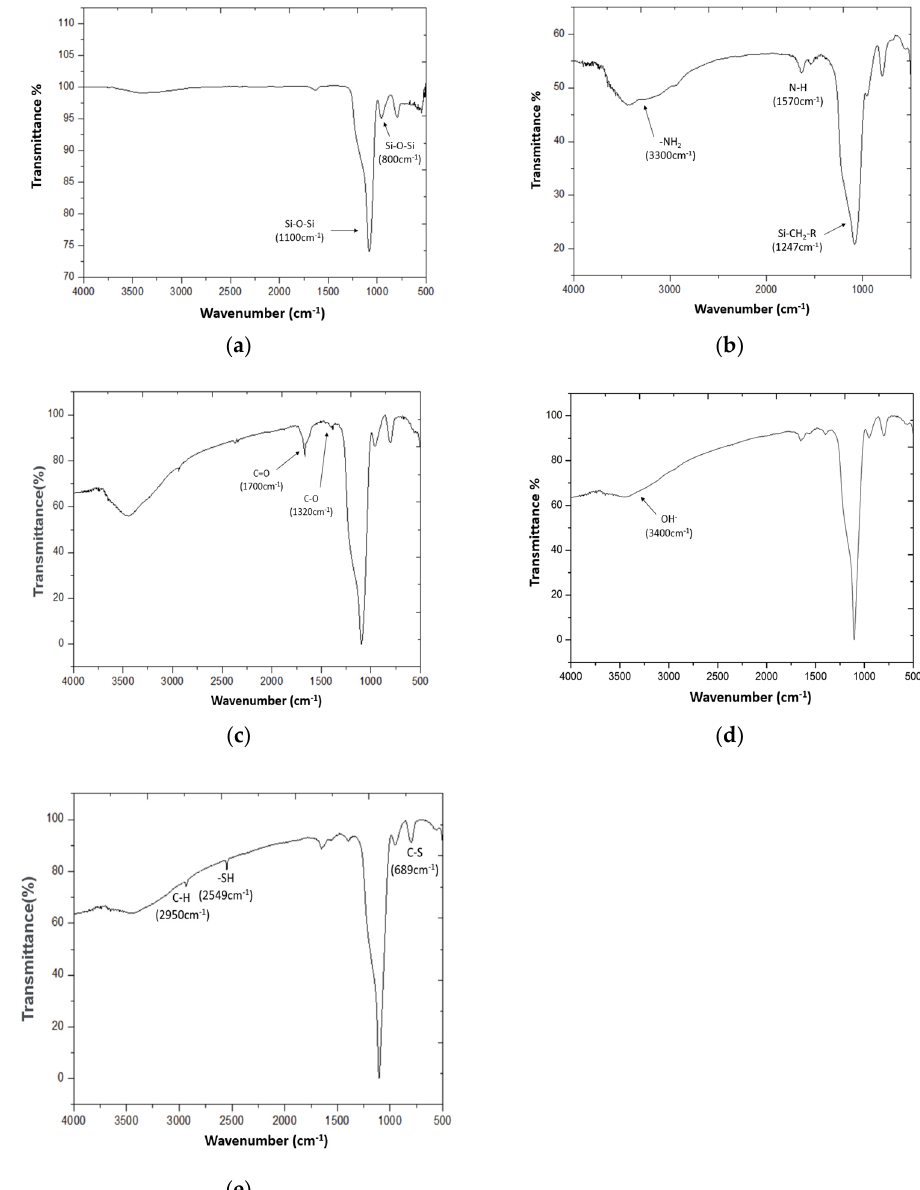
Figure 3. Typical Fourier transform infrared (FT-IR) spectra of ( a ) bare-SiO 2 ( b ) NH 2 -SiO 2 ( c ) COOH- SiO 2 ( d ) OH − -SiO 2 and ( e ) SH-SiO 2 .